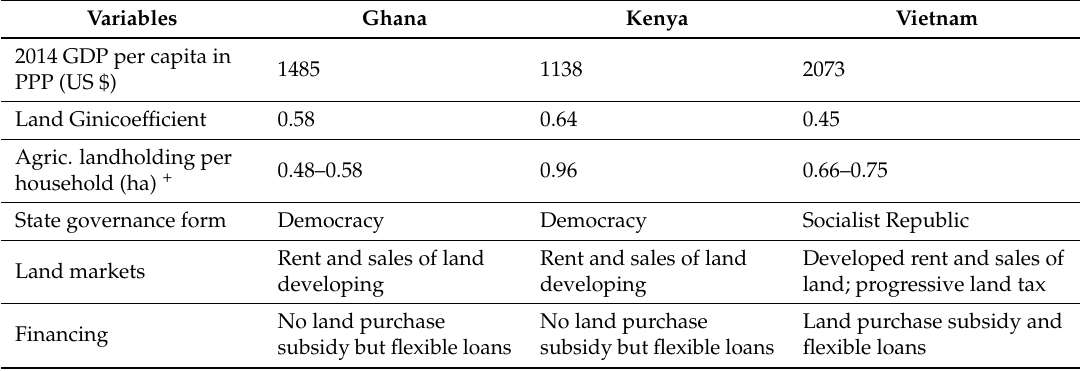
Table 1. Selected key variables of case study countries